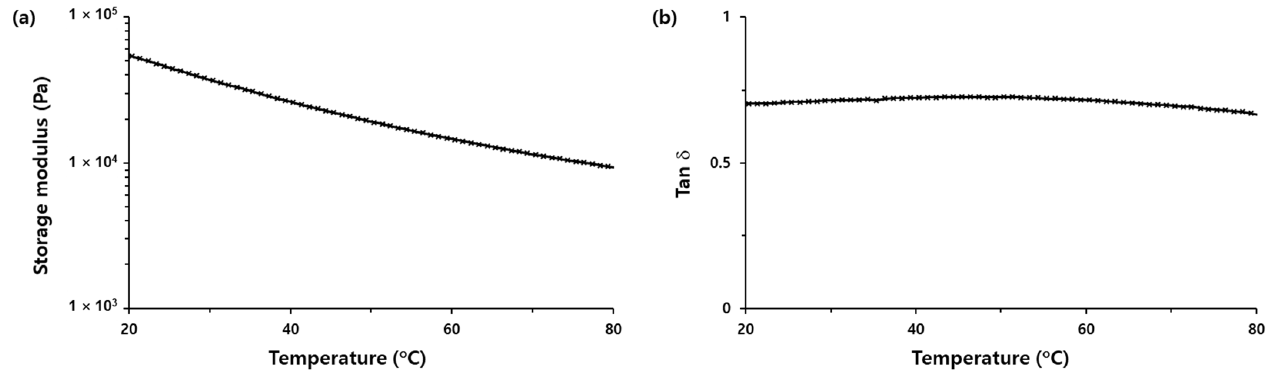
Figure 4. Temperature dependence of ( a ) storage modulus and ( b ) tan δ of h-PSA.